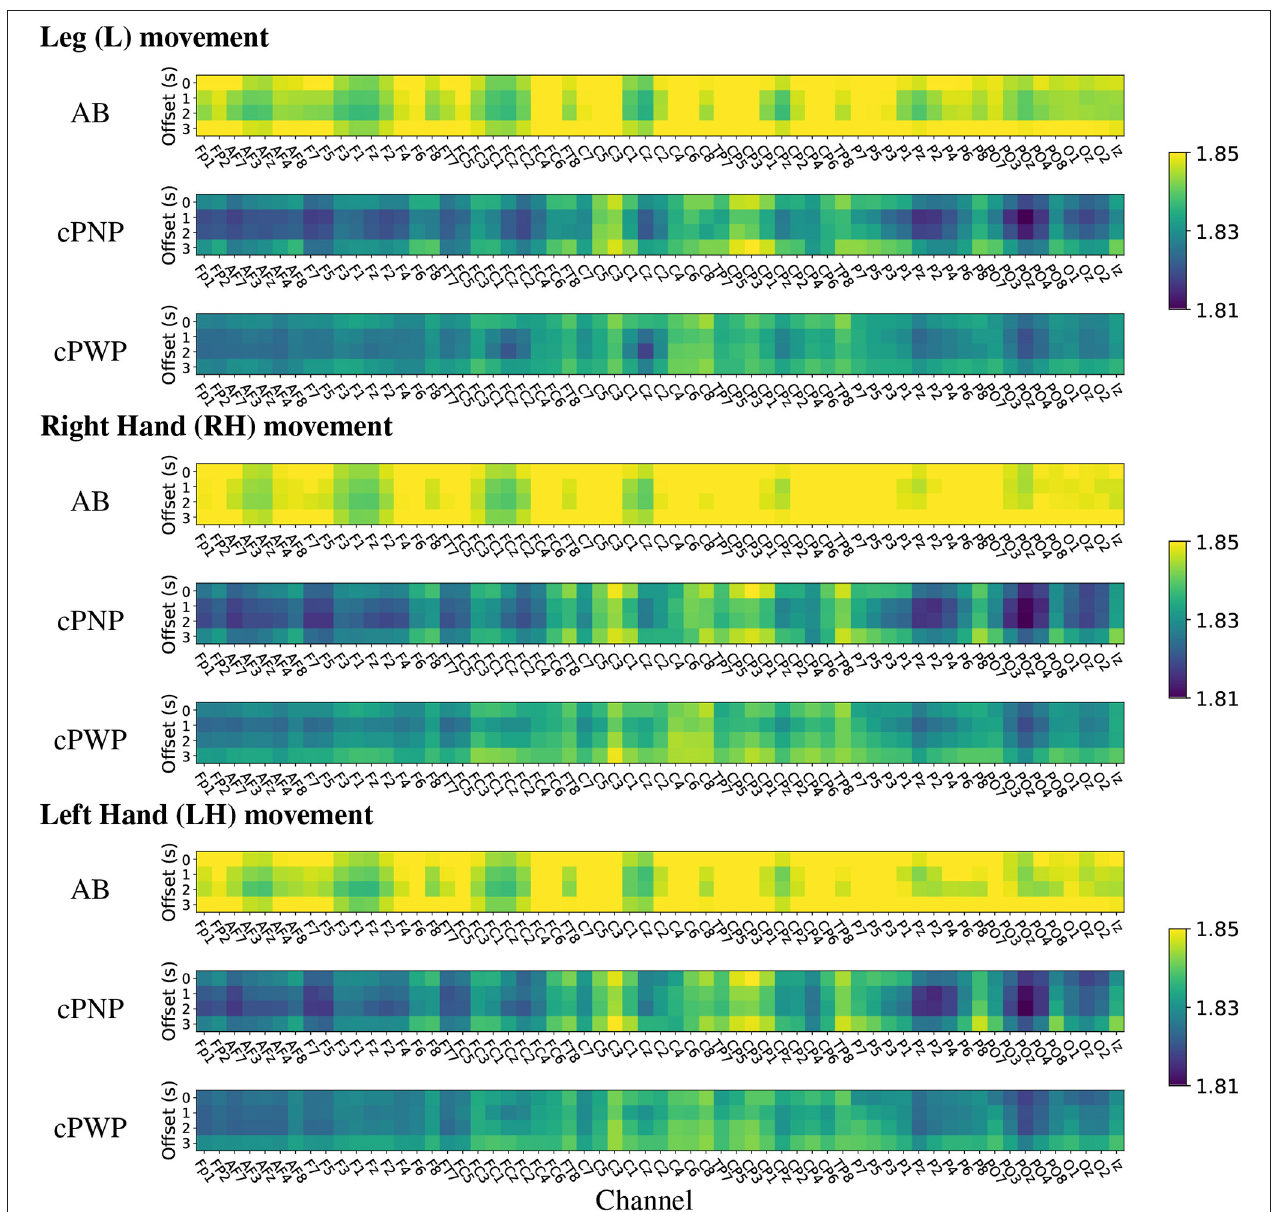
FIGURE 7 | (Dataset 1) Heat maps of group-wise mean Higuchi Fractal Dimension features extracted from EEG signals recorded during movement imagination from able-bodied volunteers (AB), participants with chronic SCI and no pain (cPNP), and participants with chronic SCI and chronic CNP (cPWP). Colours represent low (blue), medium (green), and high (yellow) mean HFD values ordered by channel along the x-axis and by time offset along the y-axis.